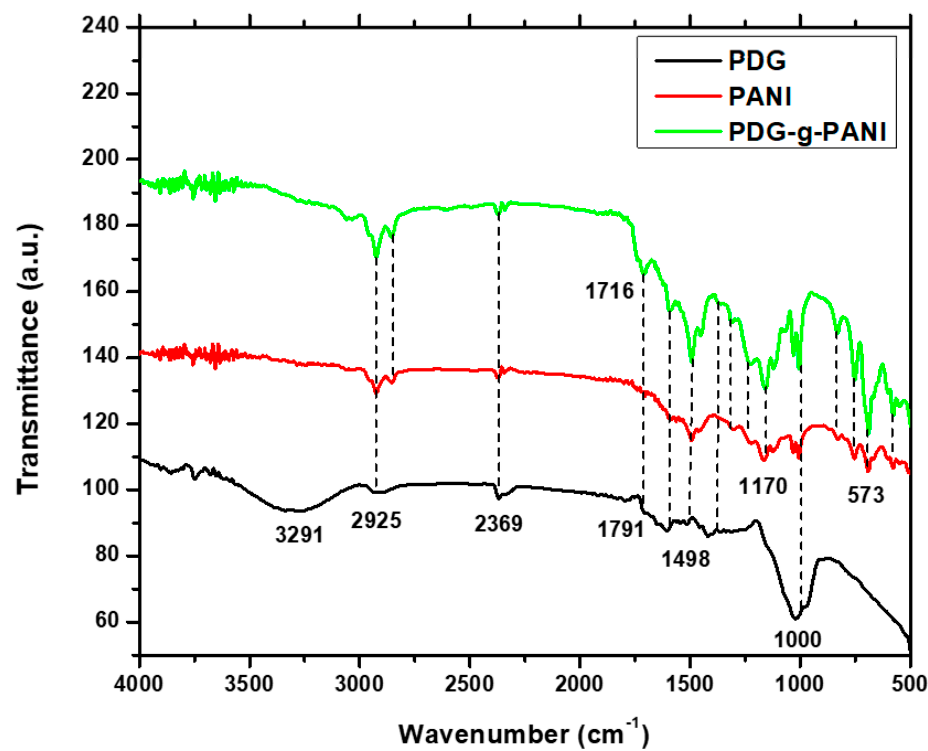
Figure 3. FTIR spectra of pristine PANI, PDG, and PDG-g-PANI.